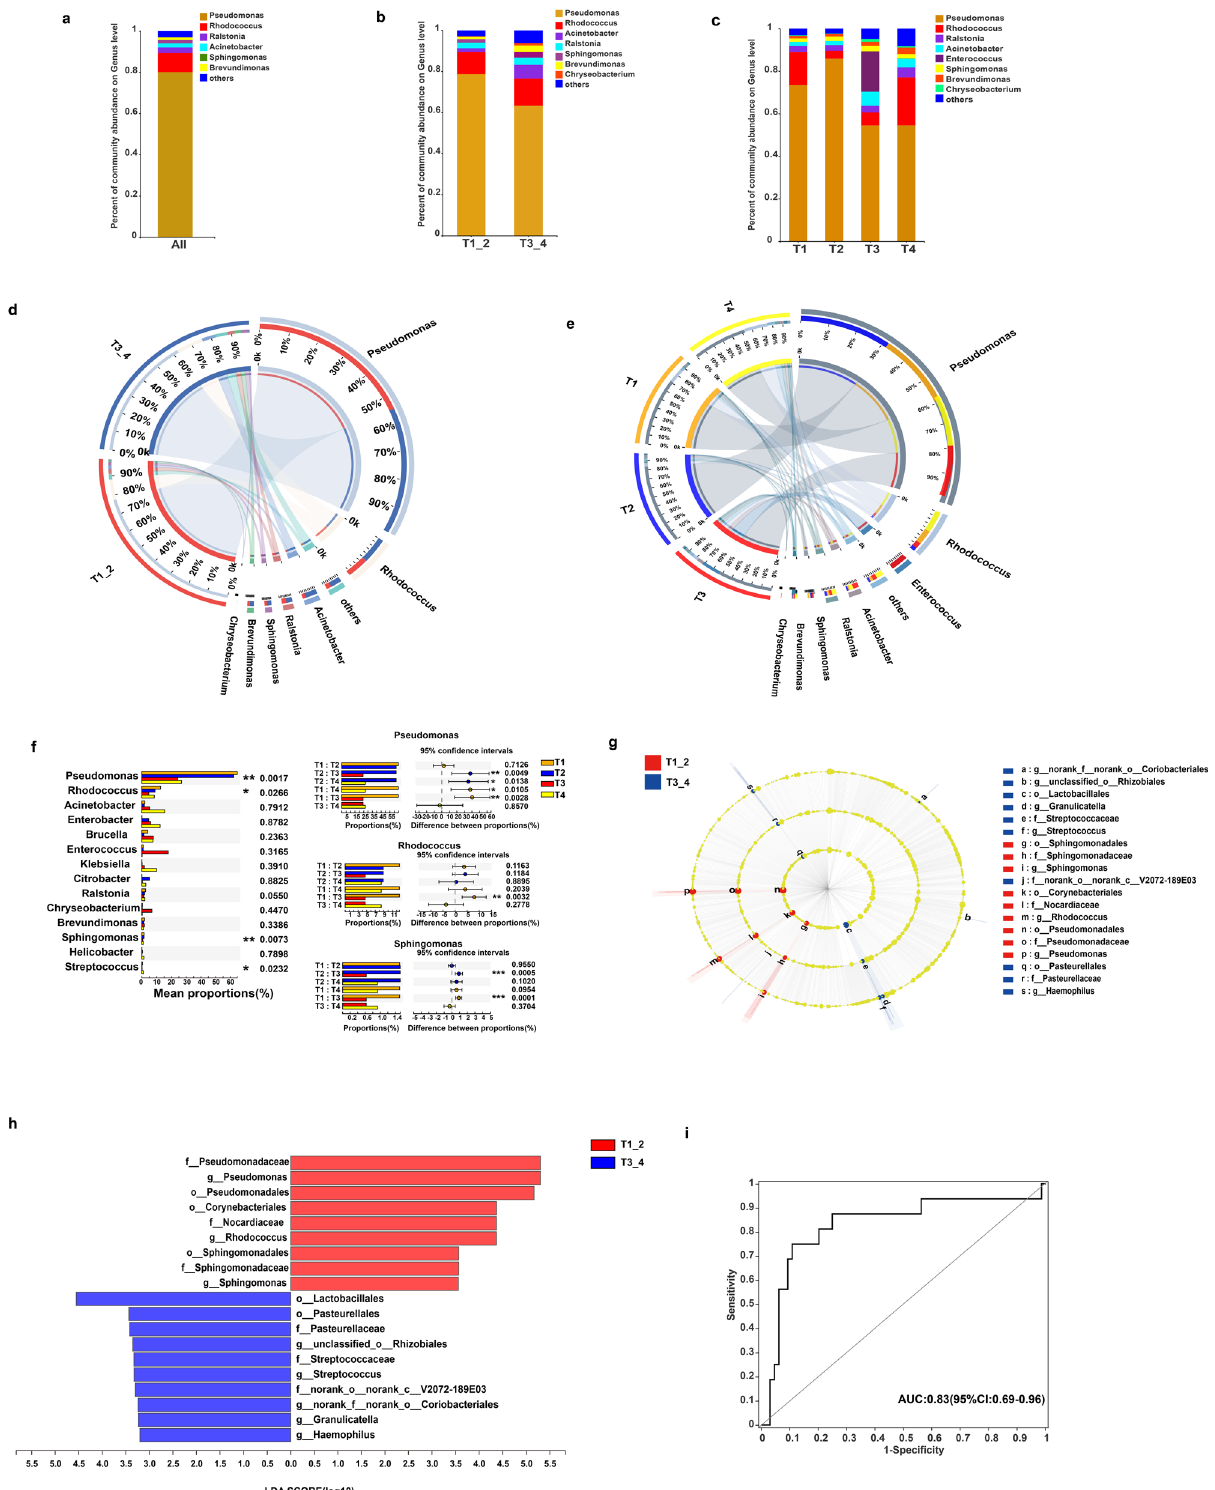
Furthermore, the association among the thyroid-related hormones free T4 (FT4), T4, FT3, T3, and thyroid-stimulating hormone (TSH) and microbial abundance were assessed. The levels of different thyroid hormones were related to different microbial genera (Fig. 3a and Supplementary Fig. S4a, Supple- mentary Data 6). A positive relationship was observed between FT4 and Neisseria and norank_f__norank_o__Chloroplast, FT3,